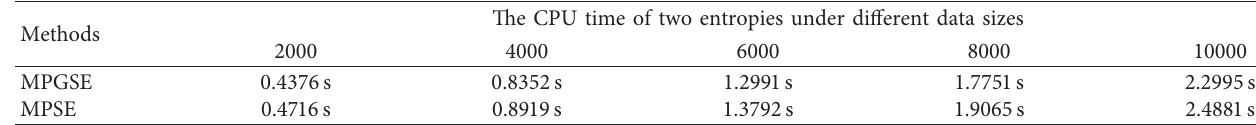
Table 3: CPU running time of MPGSE and MPSE for 1/ f